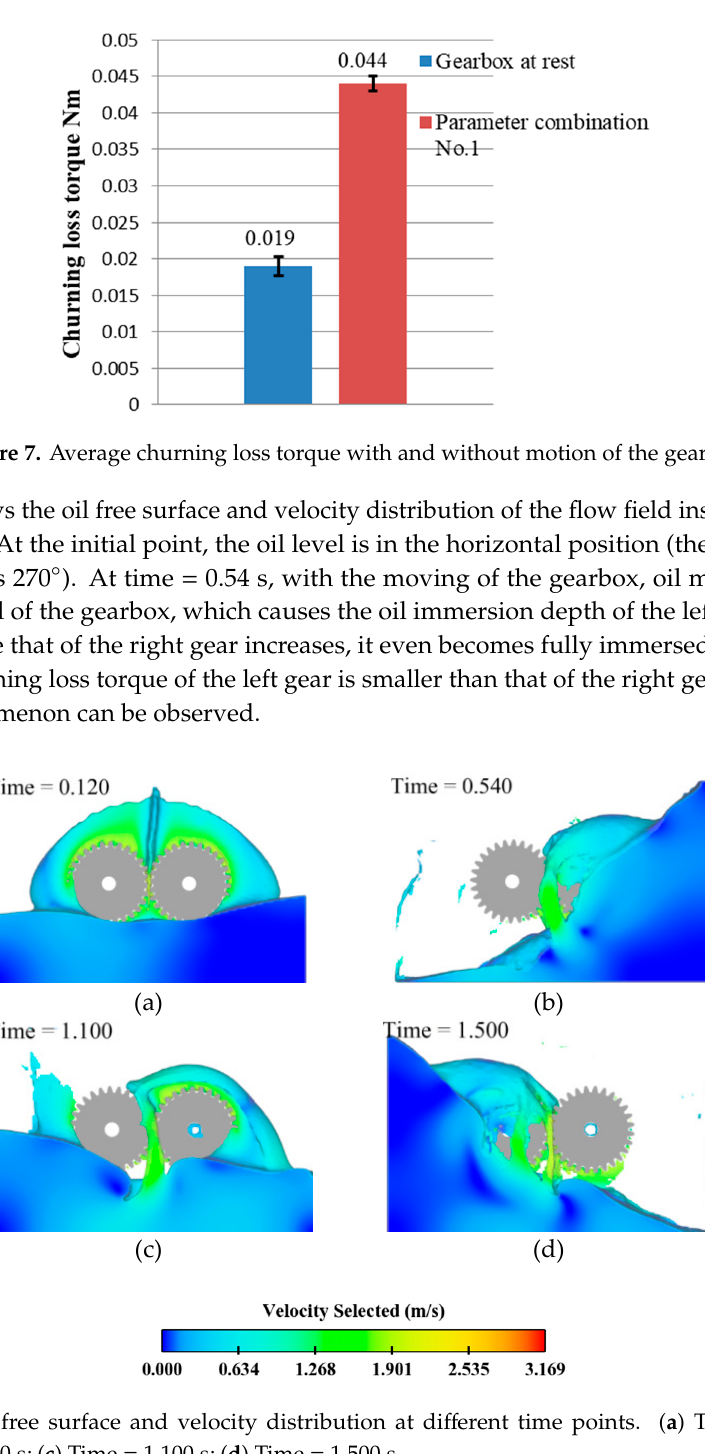
Figure 6. Time history curves of churning loss torques of parameter combination No. 0 and No. 1.